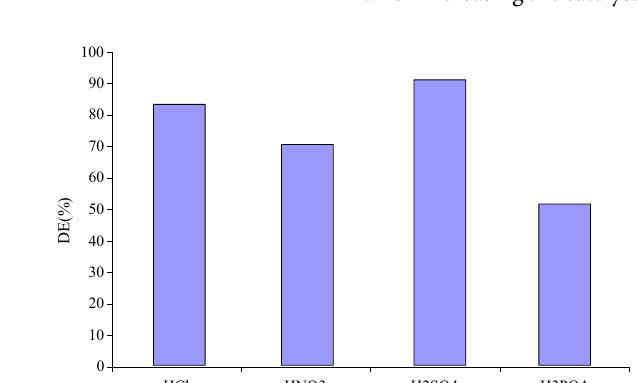
Fig. 3: Effect of the nature of the acid used to adjust the pH (pH = 3, C